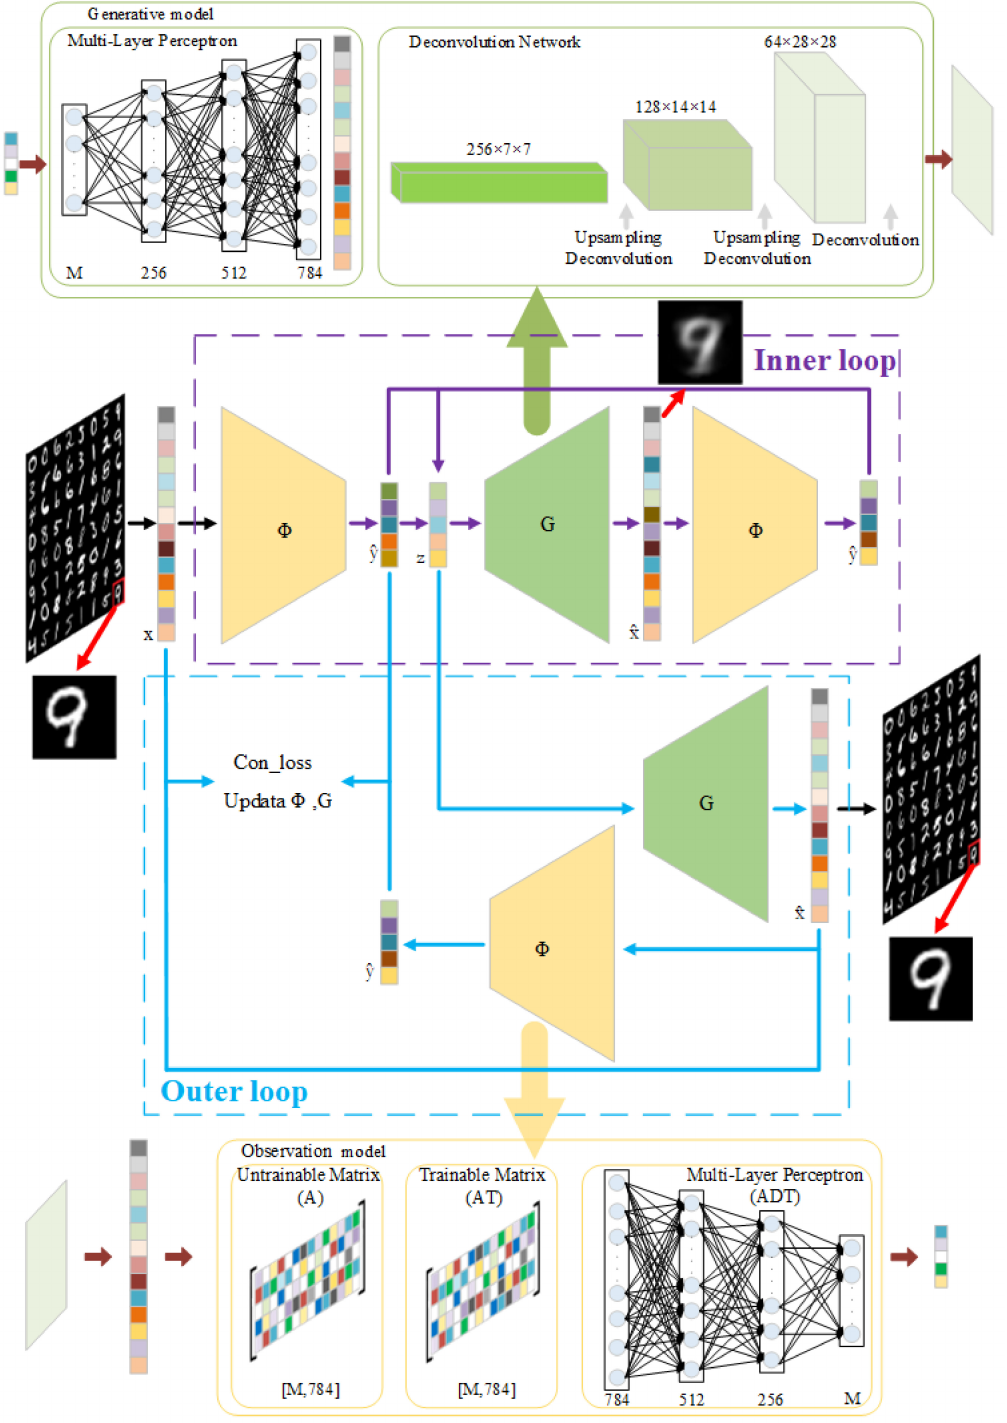
Figure 1. Block diagram to the E2E_DCSGM